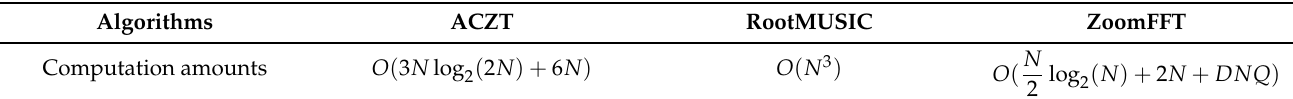
Table 1. The computational complexity of the